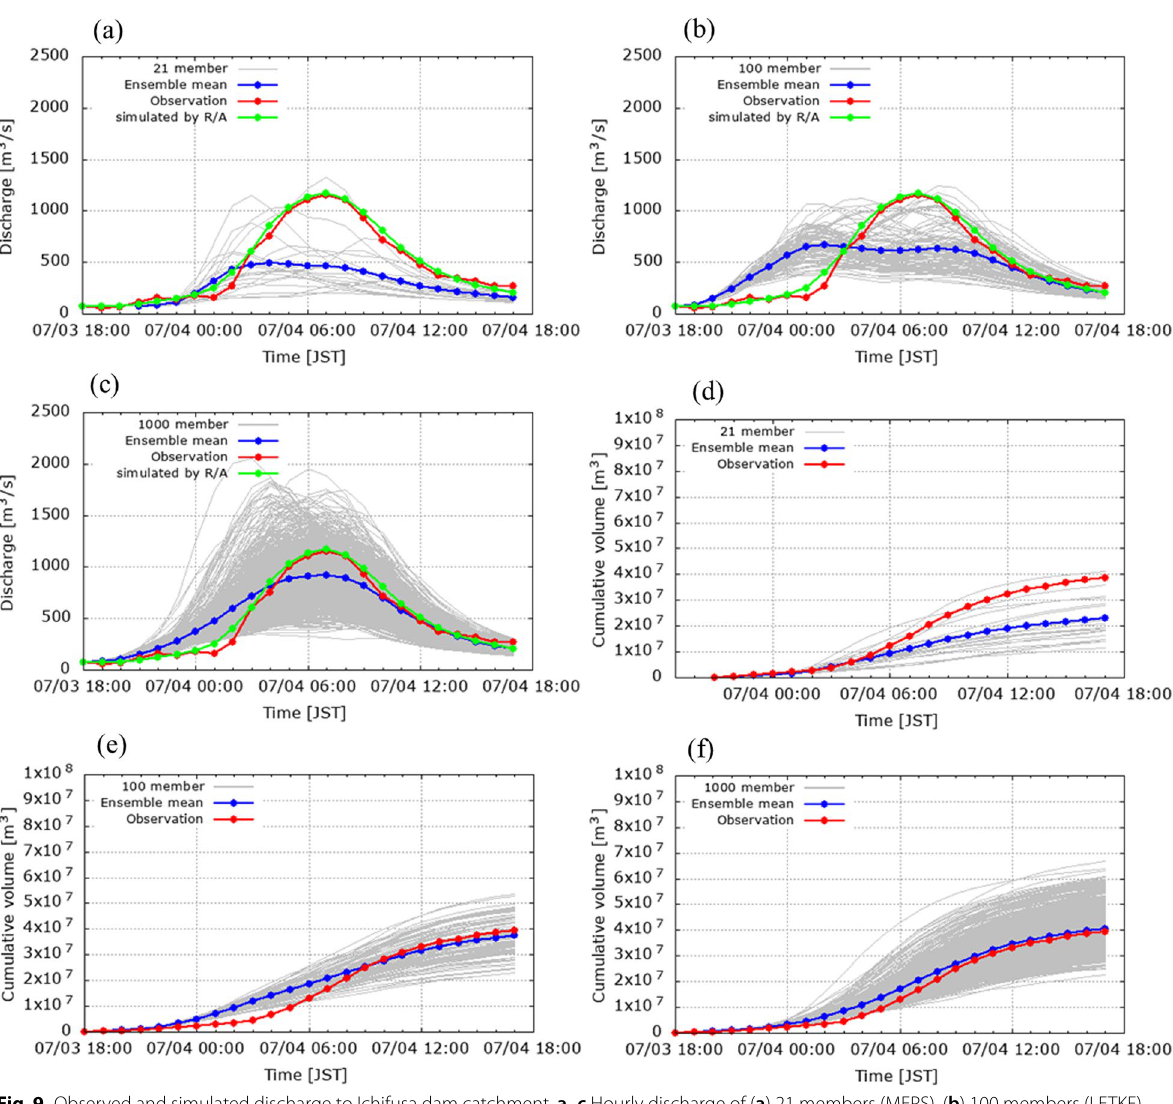
Fig. 9 Observed and simulated discharge to Ichifusa dam catchment. a – c Hourly discharge of ( a ) 21 members (MEPS), ( b ) 100 members (LETKF) and ( c ) 1000 members (LETKF). d – f Cumulative discharge for ( d ) 21 members (MEPS), ( e ) 100 members (LETKF) and ( f ) 1000 members